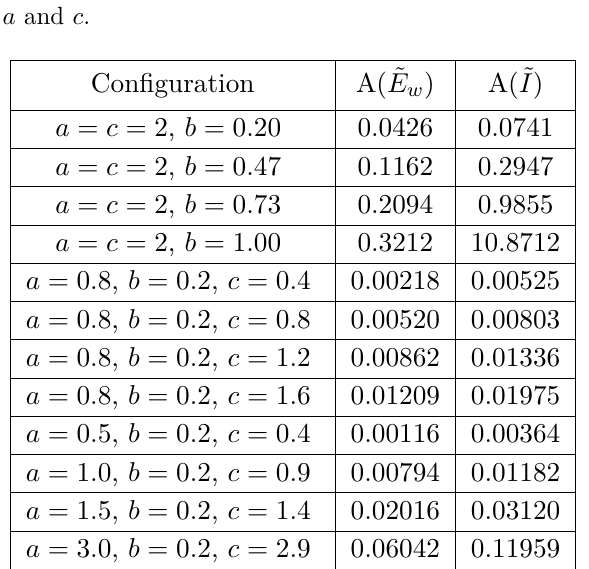
Figure 16 . The relative value of MI and EWCS near the critical point. The dashed lines represent ˜ I and the solid lines represent ˜ E ˜ I and ˜ E w . The inset plot is the slope of w . Left plot: we fix the subsystems a = c = 2 and change the separation b . Right plot: we fix the separation b = 0 . 1 and change the subsystem a and c .